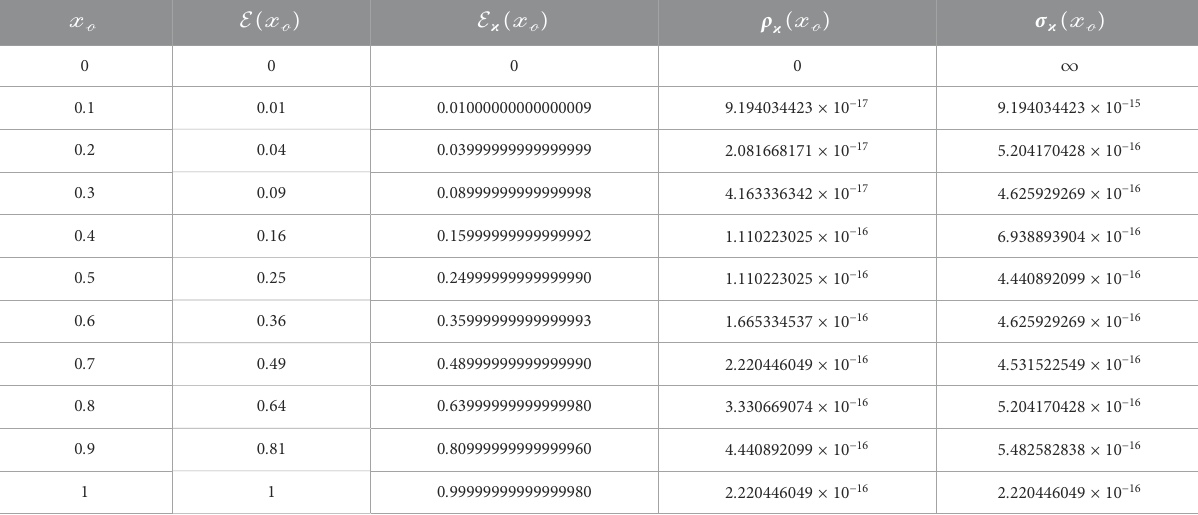
TABLE 1 Associated RKHA scores for application 1 with 8 (cid:2) 101 , when ( α , β ) (cid:2) ( 1 / 2 , 4 / 5 ) .